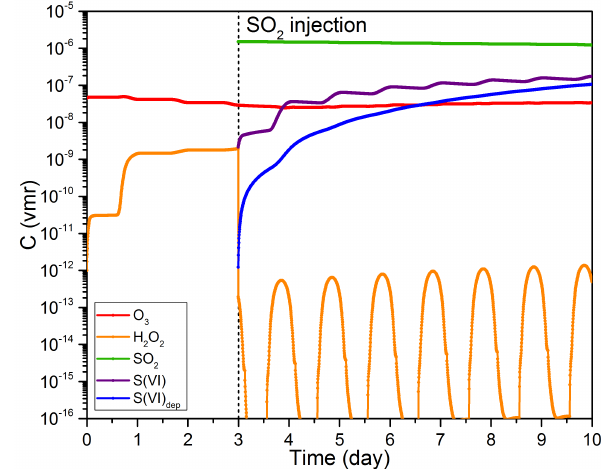
Figure 5. Time evolution in the gas-phase concentrations of SO 2 , its tropospheric oxidants and produced and deposited sulfates dur- ing S2. During the S2 simulation the concentration of injected SO 2 drops from 1.5ppmv to a final value of